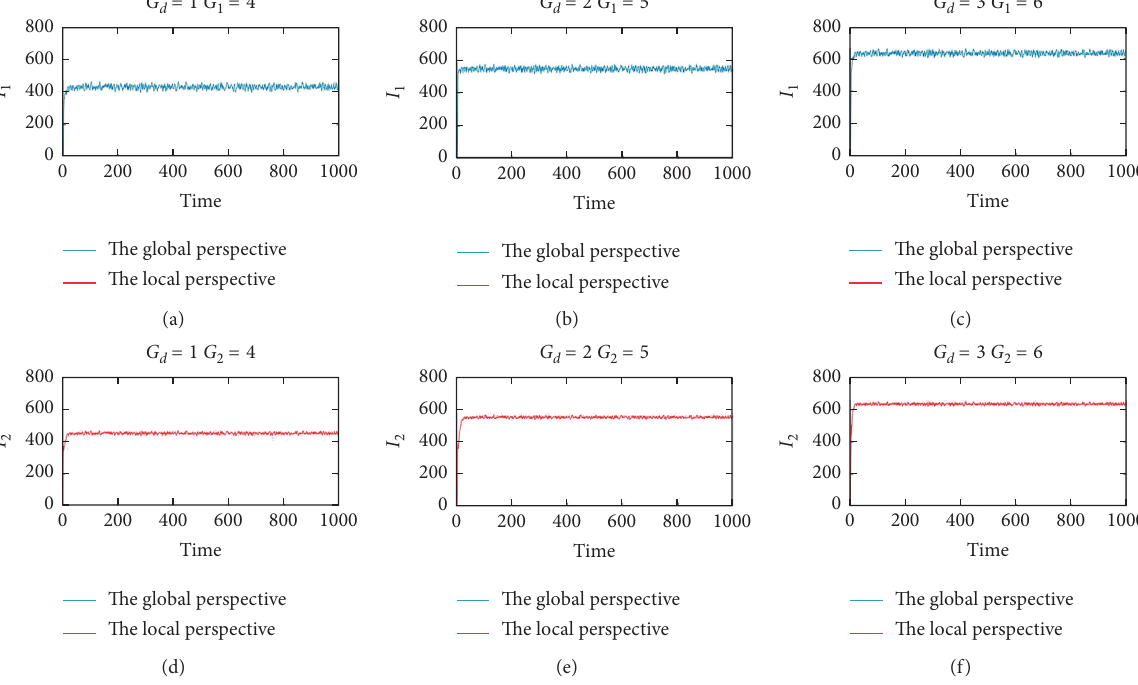
Figure 25: The initial inventory changes of the system from the perspective of decision under the scenario of random demand obeying uniform distribution from different perspectives.